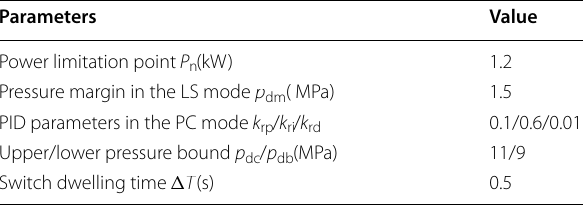
Table 4 Parameters in the proposed